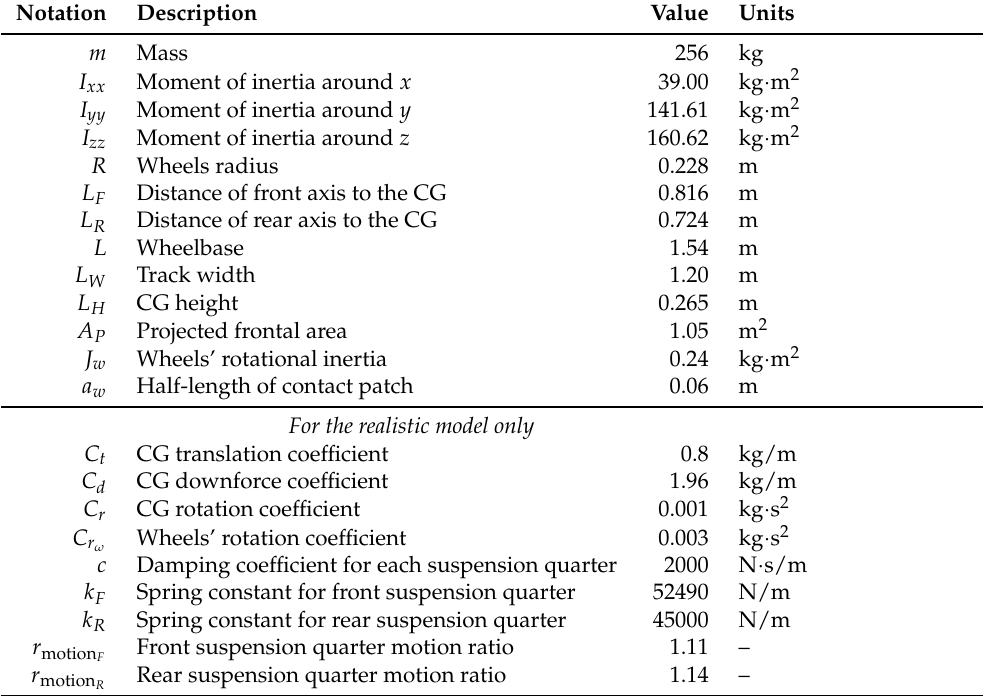
Table 1. Vehicle model